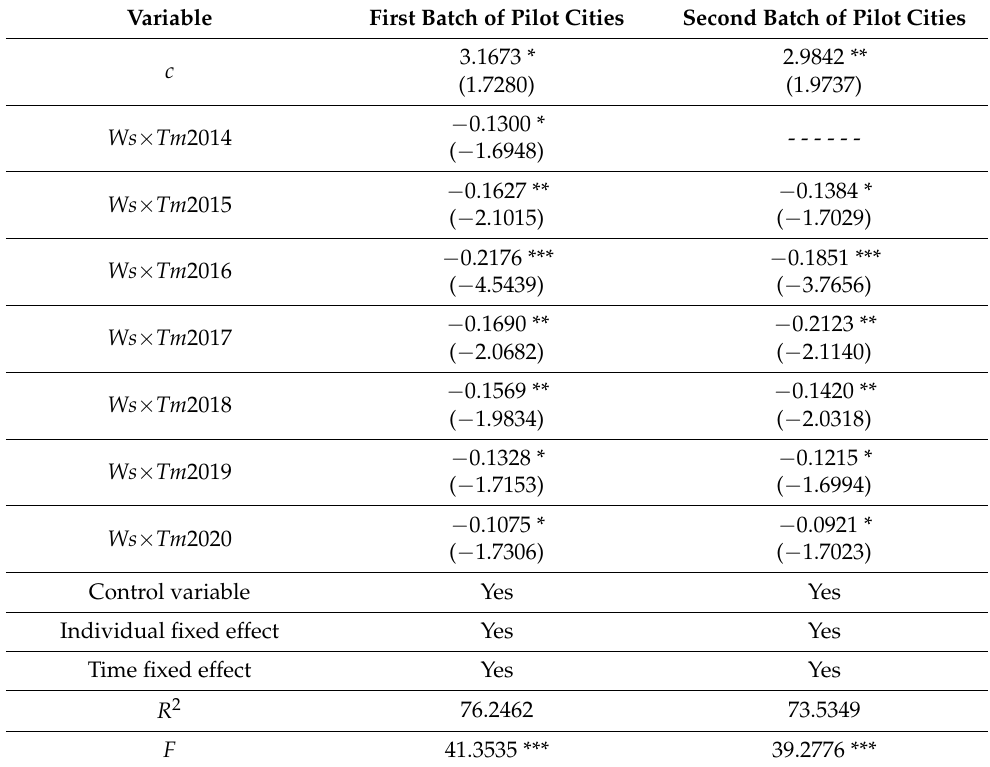
Table 7. Estimation results of time